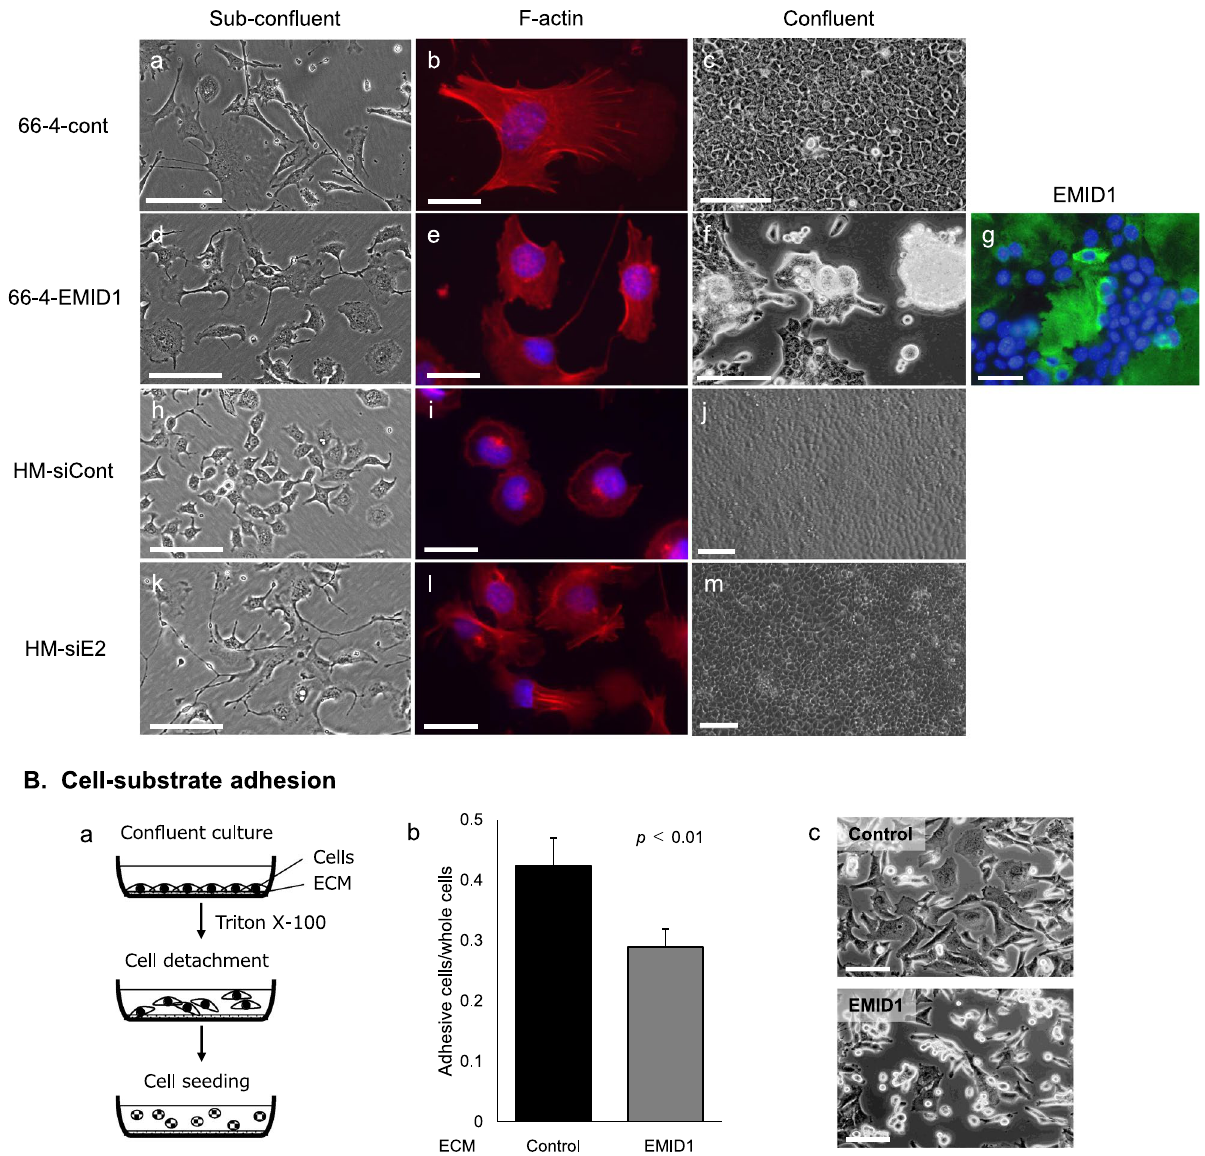
Figure 4. Effects of EMID1 expression on cell morphology and adhesion in vitro. ( A ) Morphological changes associated with EMID1 overexpression and EMID1 knockdown. Phase contrast images in sparse conditions (a, d, h, k). Scale bar, 100 μm. Filamentous actin formation stained with phalloidin conjugated with rhodamine (b, e, i, l). Scale bar, 50 μm. Phase contrast images (c, f, j, m) and immunofluorescence with EMID1 antibody (g) in confluent conditions. Scale bar, 100 μm. ( B ) Effect of EMID1 deposition on cell-substrate adhesion. A schematic diagram of the following experiment (a). The image was drawn using Microsoft PowerPoint 2016, https:// www. micro soft. com/ en- US/ downl oad/ detai ls. aspx? id= 53373. The number of cells adhering to the dish in which EMID1-overexpressing 66–4 cells had been cultured was reduced compared to control cells (b). Phase